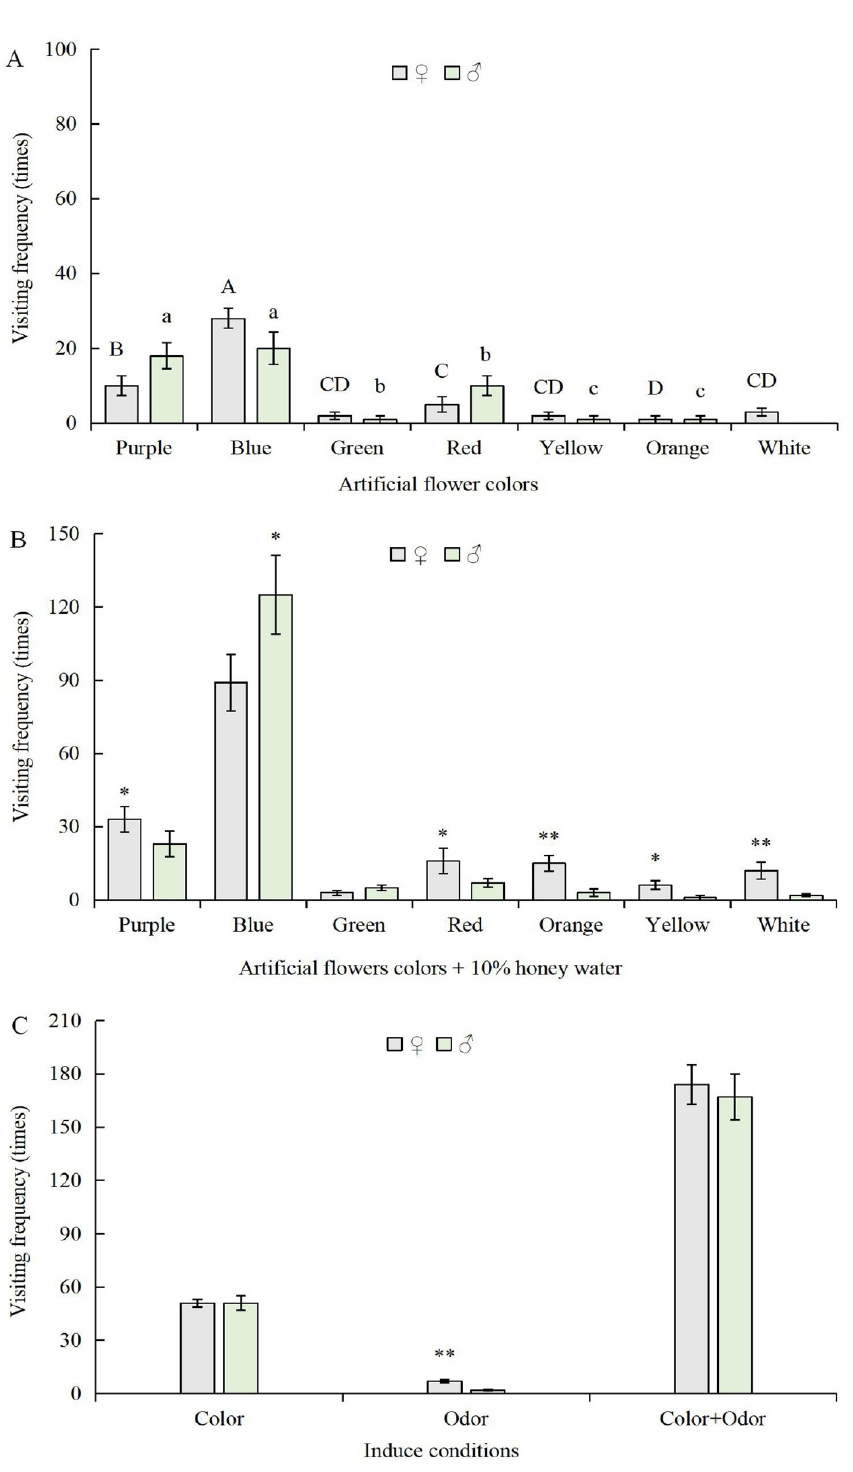
Fig 3. Response of the butterfly P . xuthus to artificial flowers of different colors and the combinations of different colors and odors. A. Response of P . xuthus to flowers with different colors. B. Response of P . xuthus to flowers sprayed with 10% honey water. C. Synergistic effects of colors and odor on butterfly behavior. Note: Capital letters indicate significant differences among the female visits to different flower colors (P < 0.05) (N = 21; LSD method); lowercase letters indicate significant differences of male visits to different colors (P < 0.05) (N = 21; LSD method); � above bars